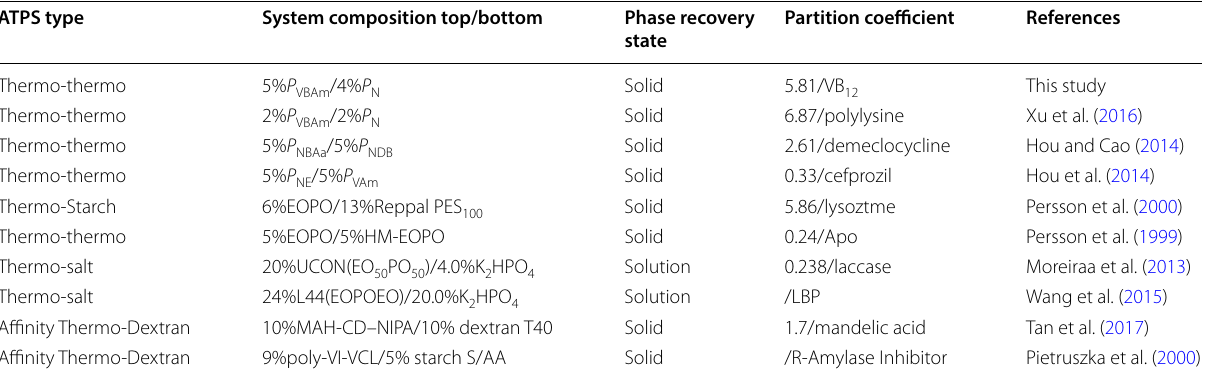
Table 4 Characteristics of the thermo-responsive ATPS ATPS